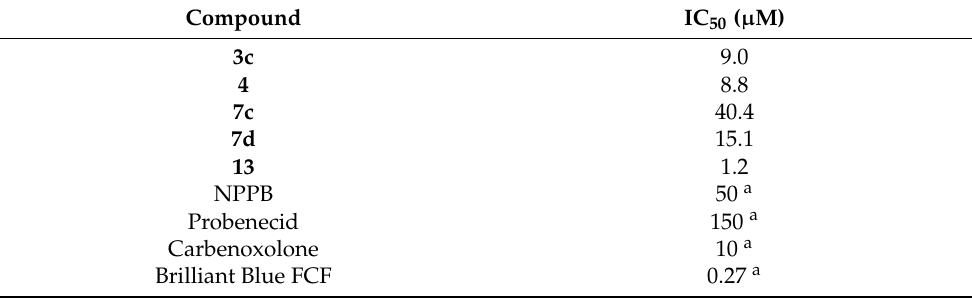
Table 4. IC 50 values of 3c , 4 , 7c , 7d and 13 and reference